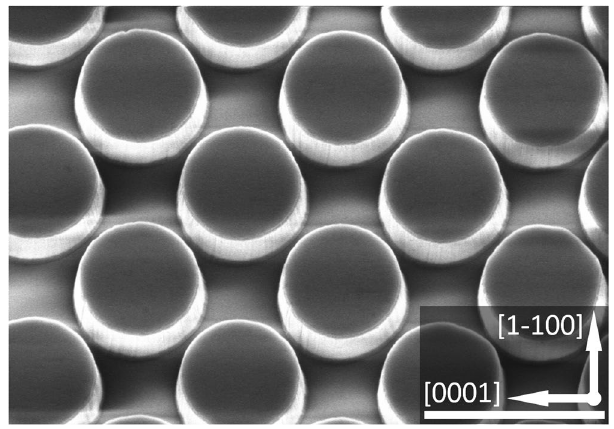
Figure 1. Plane-view SEM image of our regularly arrayed micro-rod array template. Scale bar: 4 μ